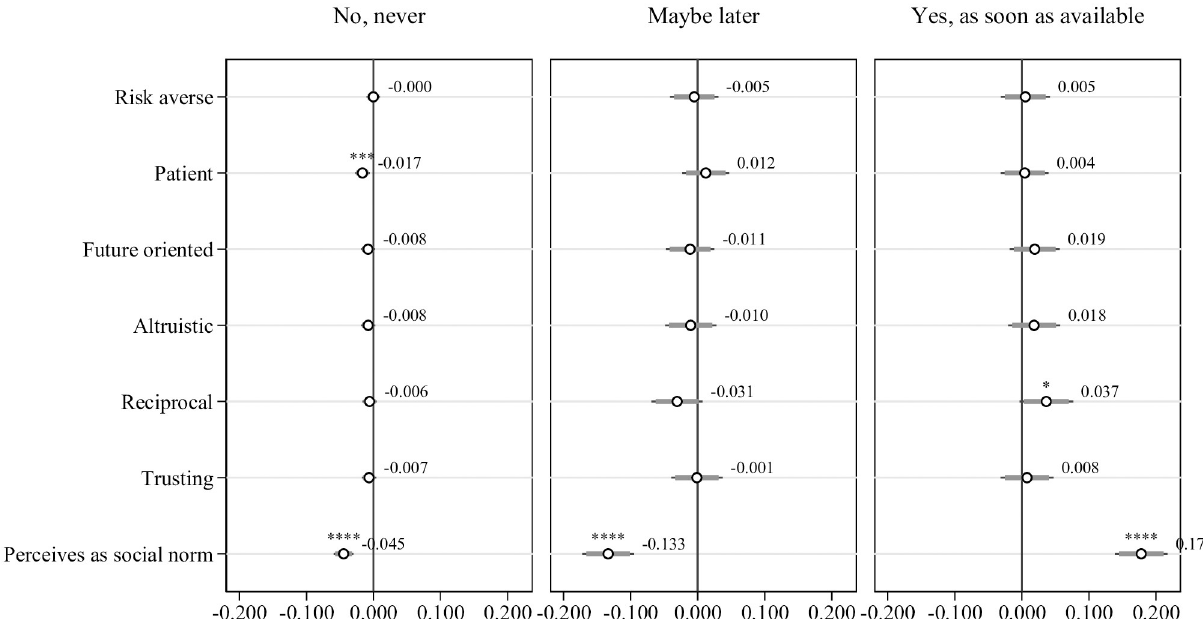
Fig 7. Multinomial probit regressions: Willingness to get vaccinated and preferences, controlling for individual and situational characteristics, and Big-5 personality traits. Dependent variable is willingness to get vaccinated. Individual characteristics include being female, being younger, education, being a healthcare worker, and being native. Situational factors include belonging to COVID-19 risk group, living with someone belonging to COVID-19 risk group, having had contact with a COVID-19 infected person outside work, having been outside Switzerland, using public transport and having had a positive test result of COVID-19 in the past. Personality traits include extroversion, agreeableness, conscientiousness, stability and openness. All regressions include hospital and time fixed effects. Standard errors in parentheses, n = 915. � p < 0.1, �� p < 0.05, ��� p < 0.01, ���� p < 0.001.